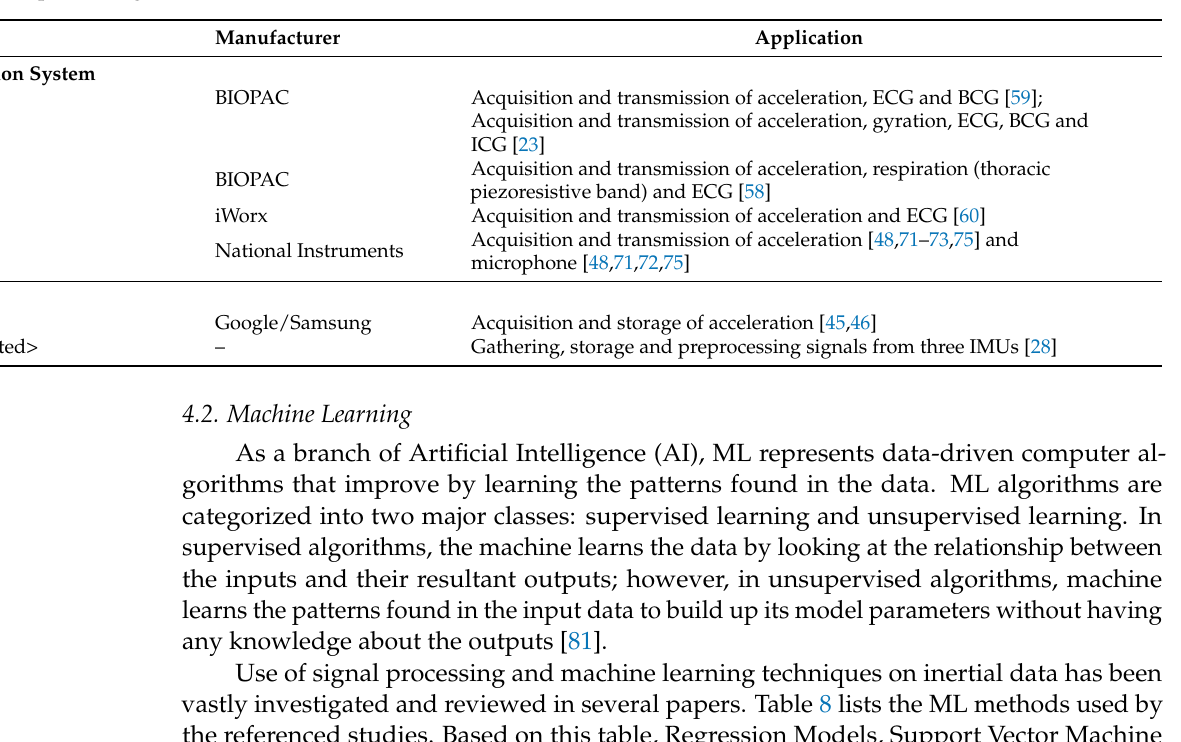
Table 7. Middleware devices used in the referenced studies to handle some part of the processing chain from on-body sensor to the processing